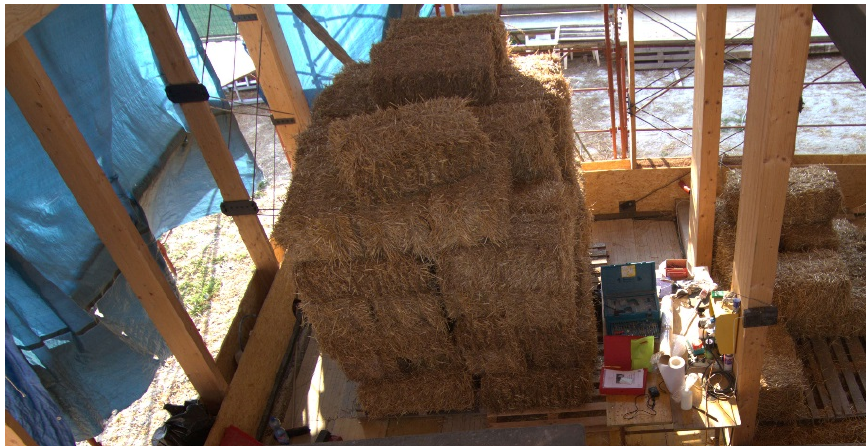
Figure 4. Example of storage inside a building.